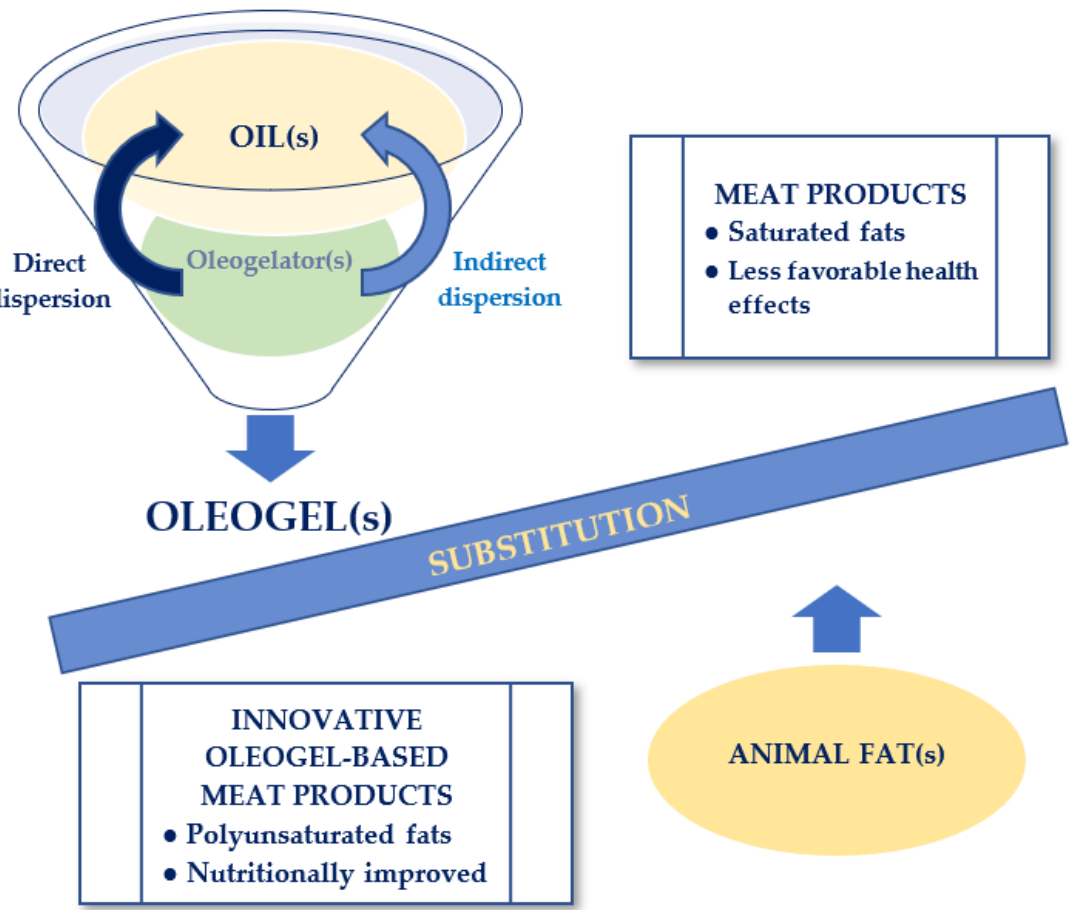
Figure 3. Viable alternative solution for animal fat substitution in meat products.